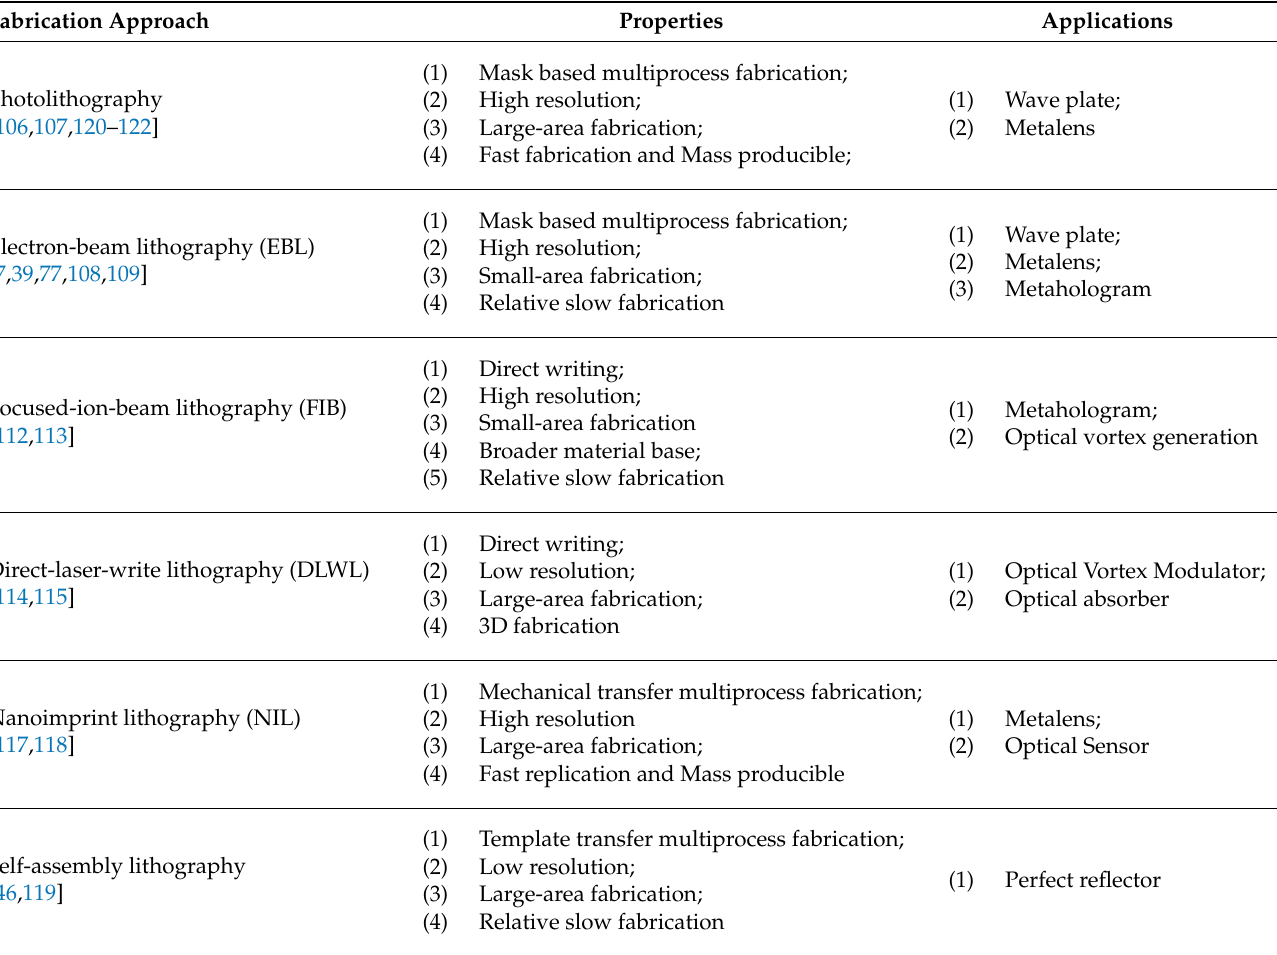
Table 2. The properties of different fabrication methods of